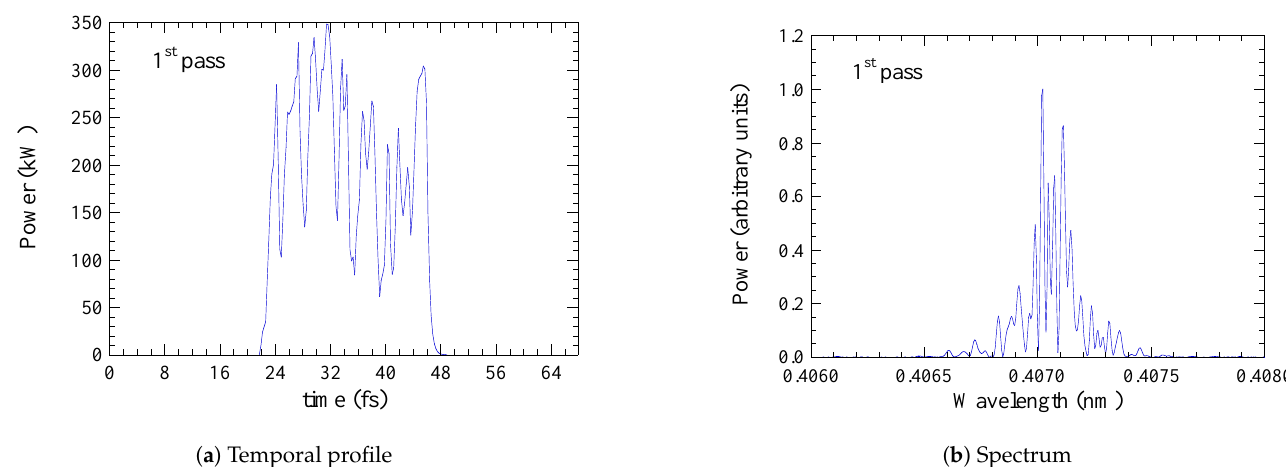
Figure 26. Temporal pulse shape and spectrum of the optical pulse at the exit of the undulator for the first pass. Other parameters as described in the text.